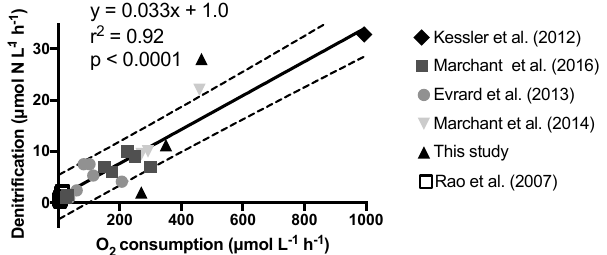
Figure 6. Denitrification rate as a function of oxygen consumption in this study and previously published studies. The solid line is the line of best fit for previous studies in silicate sands; the dashed lined are the 99% prediction interval. Data from this study are from the flow-through reactor